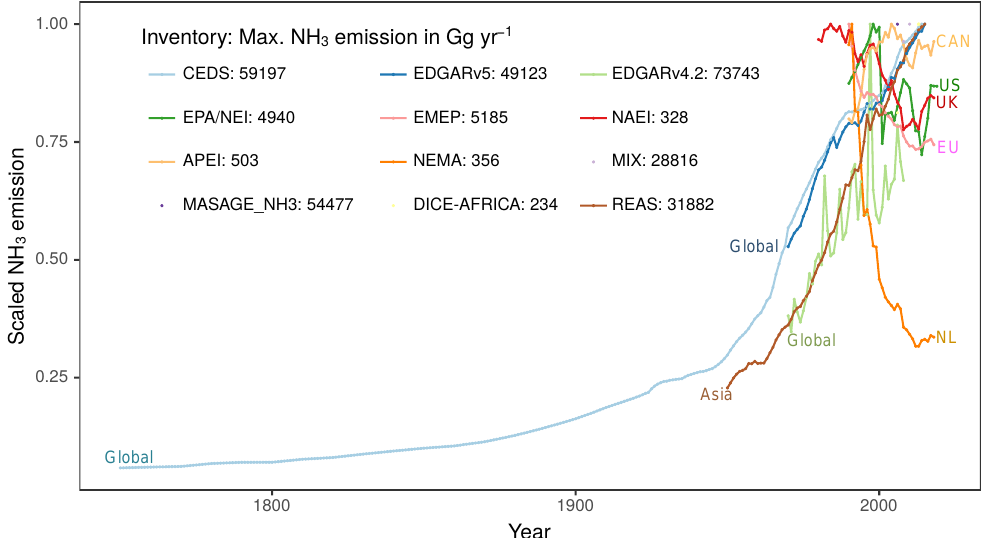
Figure 3. Time-series of annual long-term variations in ammonia emissions from multiple global and national emission inventories (listed in Table 5). The y-axis shows NH 3 emissions scaled to the maximum value, which is noted in the inset legend in the units of Gg yr − 1